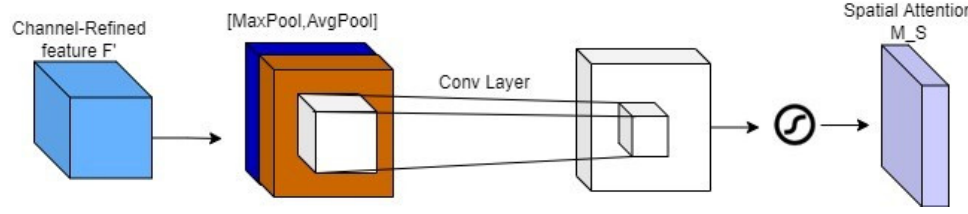
Figure 5. SAM Structure Diagram.